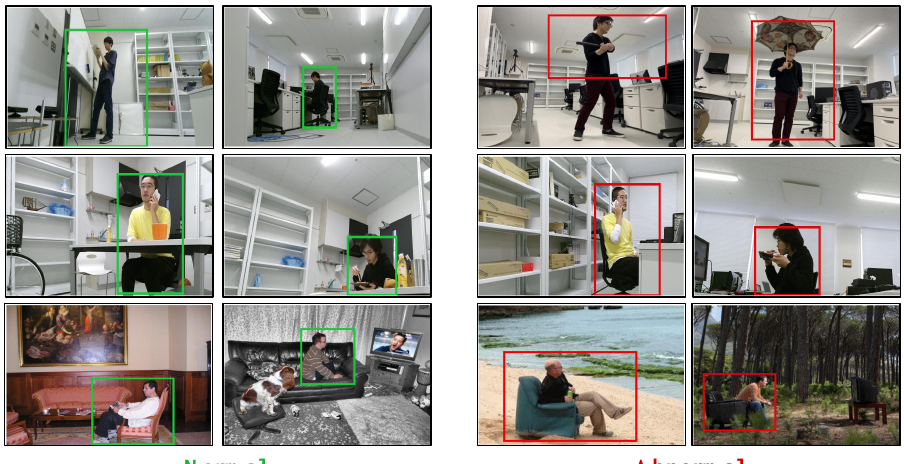
Figure 5. Examples of normal regions with green boxes and abnormal regions with red boxes. The abnormal regions in the upper row are examples of single anomalies in LabPatrolling. In contrast to the normal regions in the middle and bottom rows, the abnormal regions in the same rows are examples of contextual anomalies in BehaviorMonitoring and AnoVisualGenome,